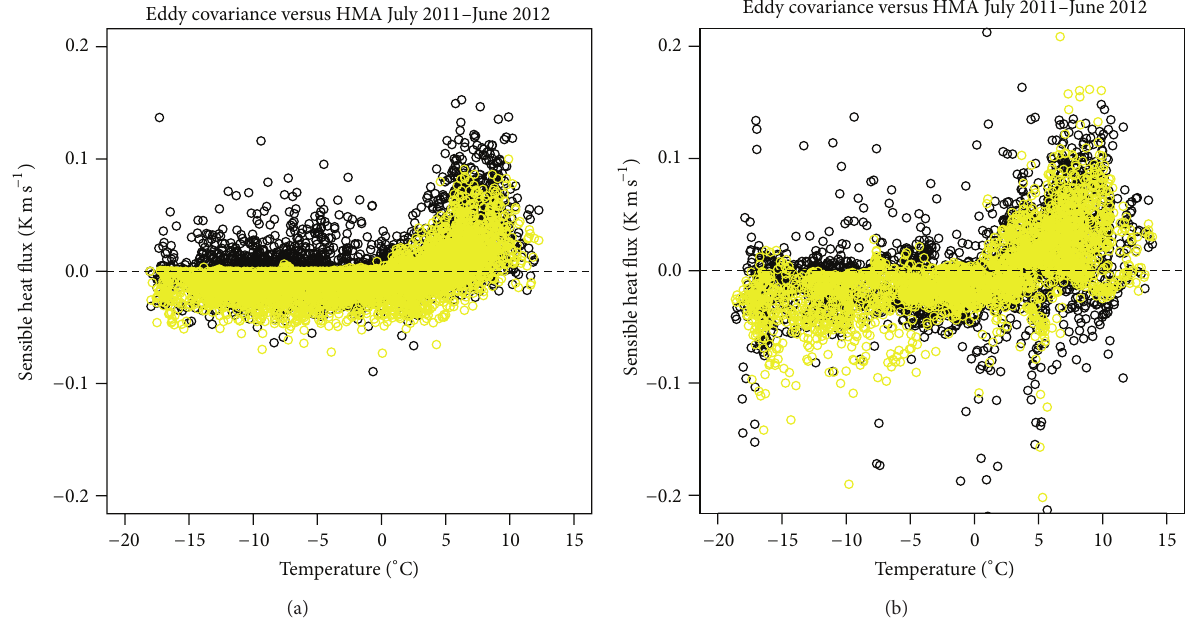
Figure 2: 30 min averages of the kinematic sensible heat flux (Kms −1 ) for the period July 2011 to June 2012, plotted against the air temperature in measurement height (eddy covariance: black dots, HMA: yellow dots): (a) sensible heat fluxes for friction velocities ≤ 0.23 ms −1 , (b) sensible heat fluxes for friction velocities > 0.23 ms −1